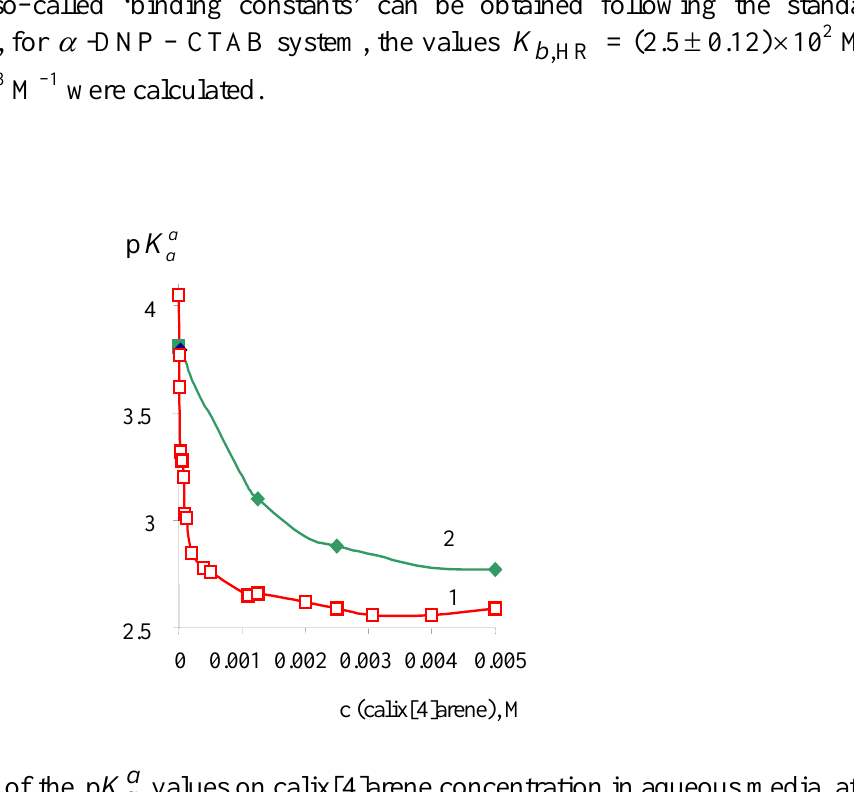
K p values on calix[4]arene concentration in aqueous media, at Figure 3. The dependence of the a a ionic strength 0.05 М (NaCl): BPB (1); α -DNP (2).